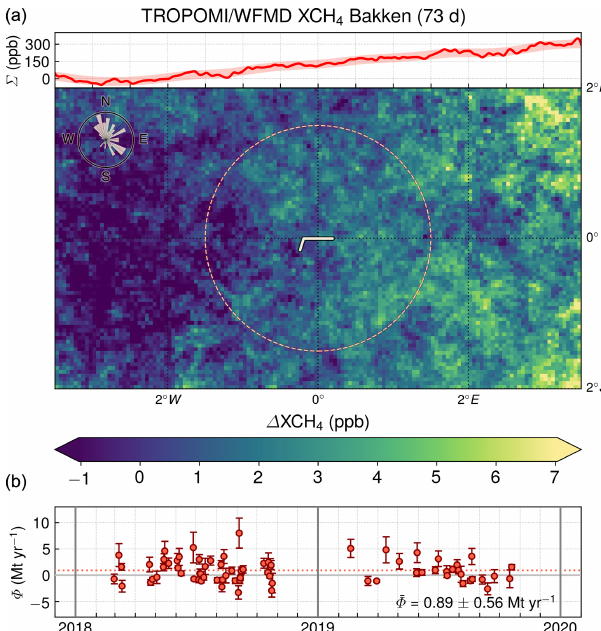
Figure 5. As Fig. 4 but for the Bakken formation. The coordinates of the pivotal point are 48 . 5 ◦ N, 103 ◦ W. The mean emission esti- mate (cid:56) corresponds to a fugitive emission rate of 1 . 3 ± 0 . 8%.